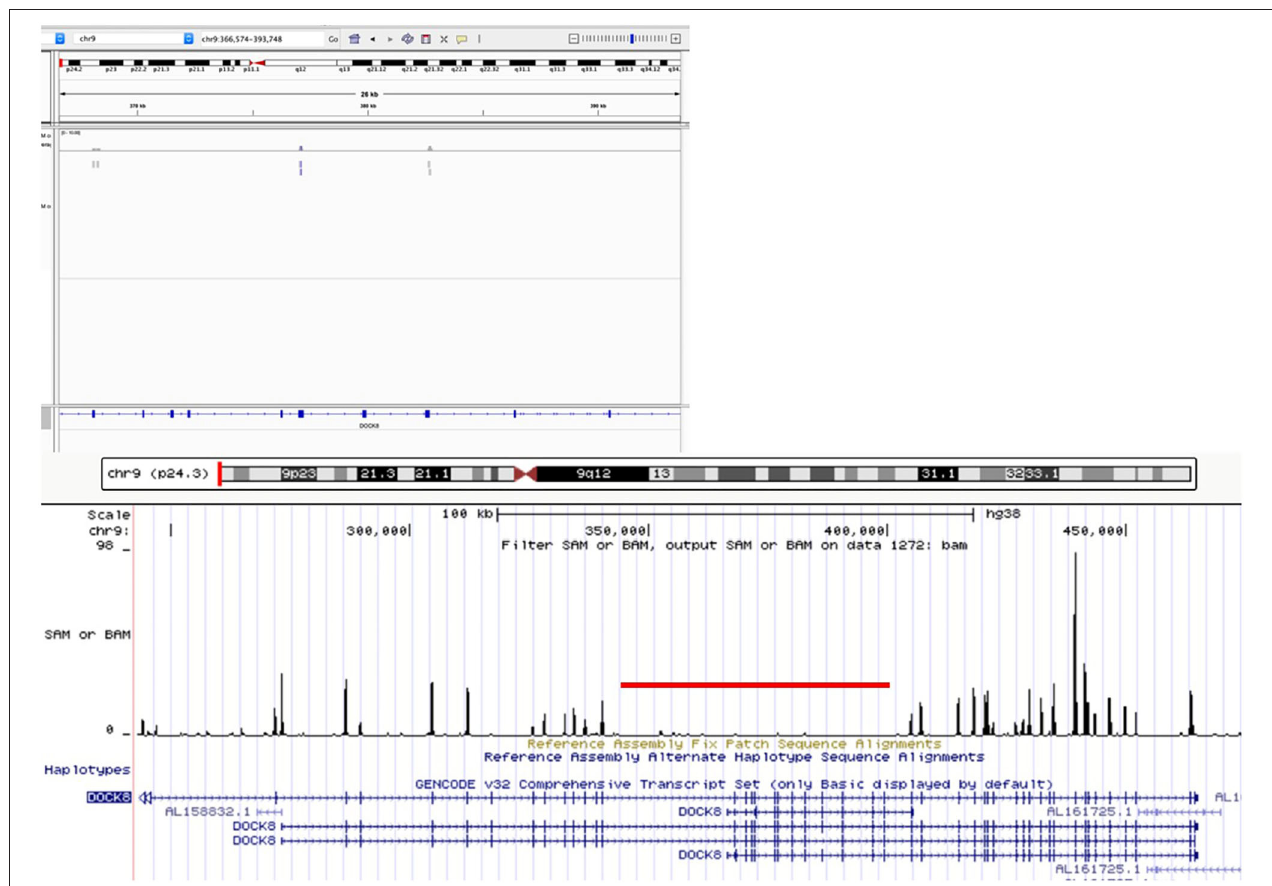
FIGURE 4 | Whole-exome sequencing visualization on Integrative Genomics Viewer (IGV) and UCSC Genome browser, showing a large homozygous deletion of DOCK8 spanning introns 14 through 26, more than 50kb.